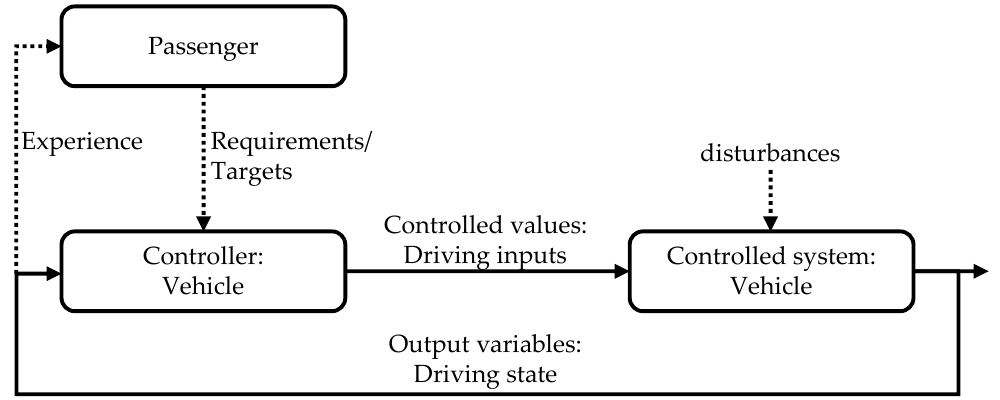
Figure 3. Control loop of highly automated and autonomous vehicles.